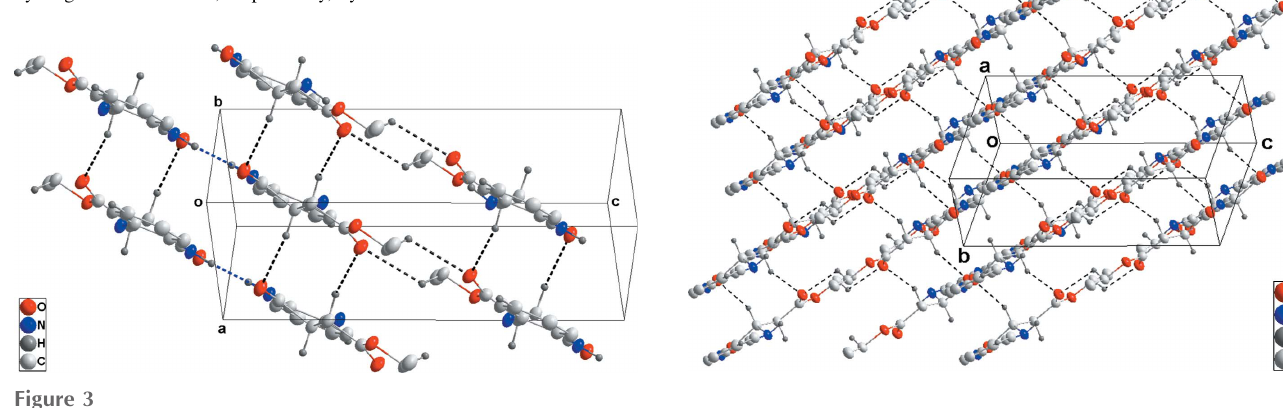
Figure 4 Packing projected onto (122) with hydrogen bonds shown as in Fig. 2.